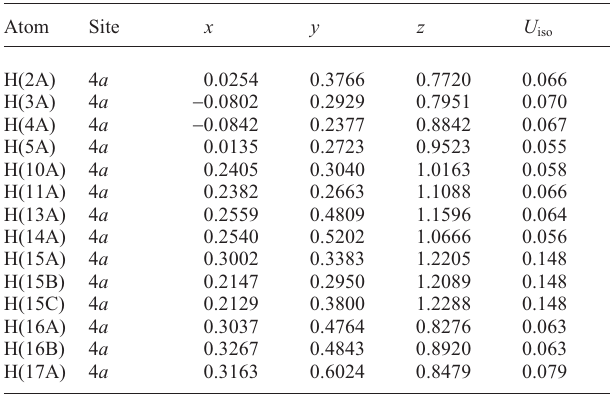
Table 2. Atomic coordinates and displacement parameters (in Å 2 )